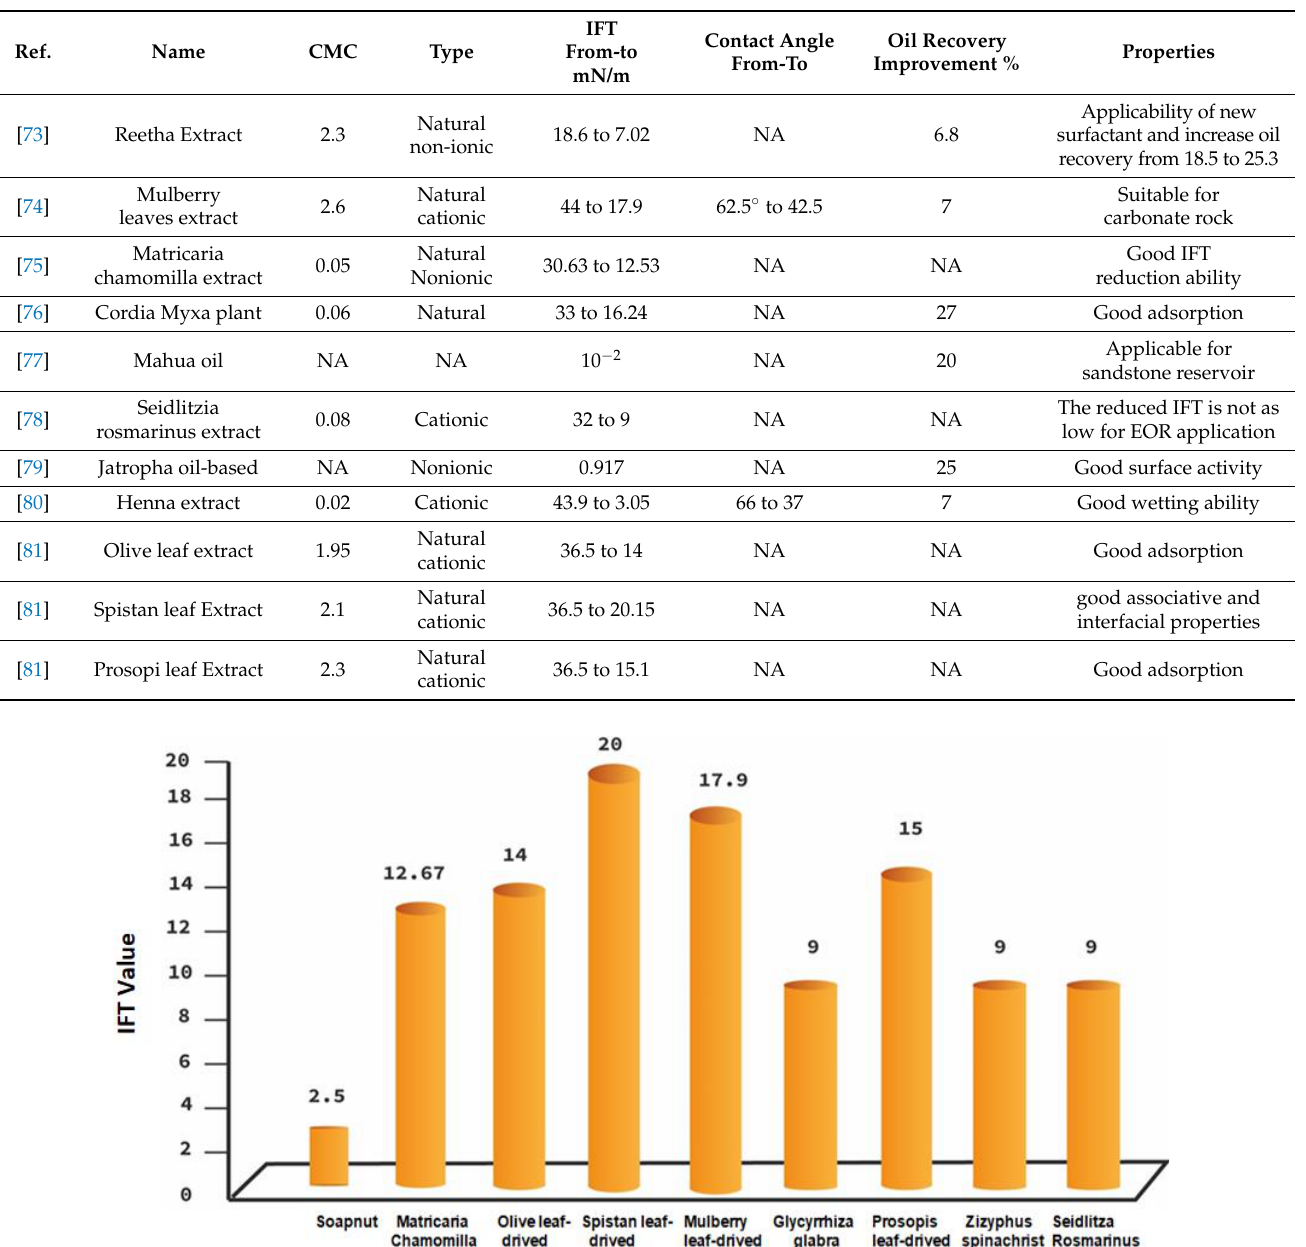
Table 2. Summary of natural surfactant types and their properties.